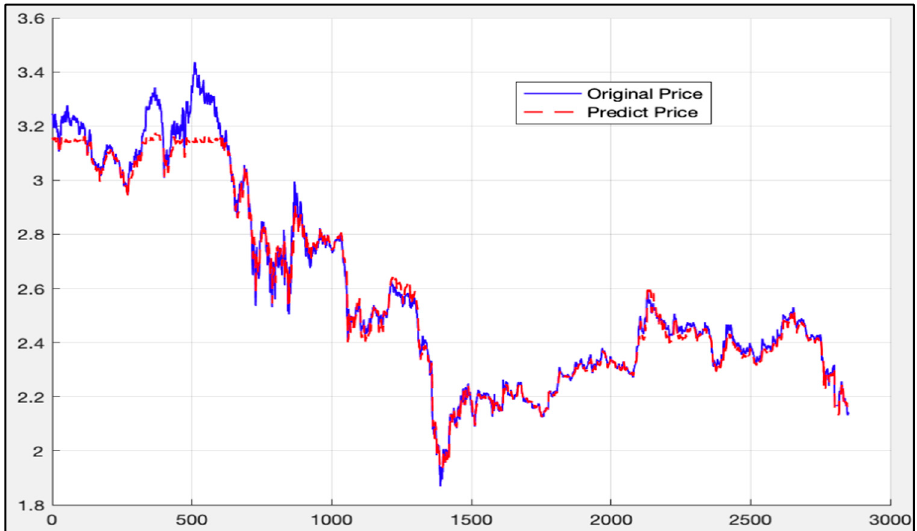
Figure 19. Comparison of RF prediction results with actual results (first 2850 data).